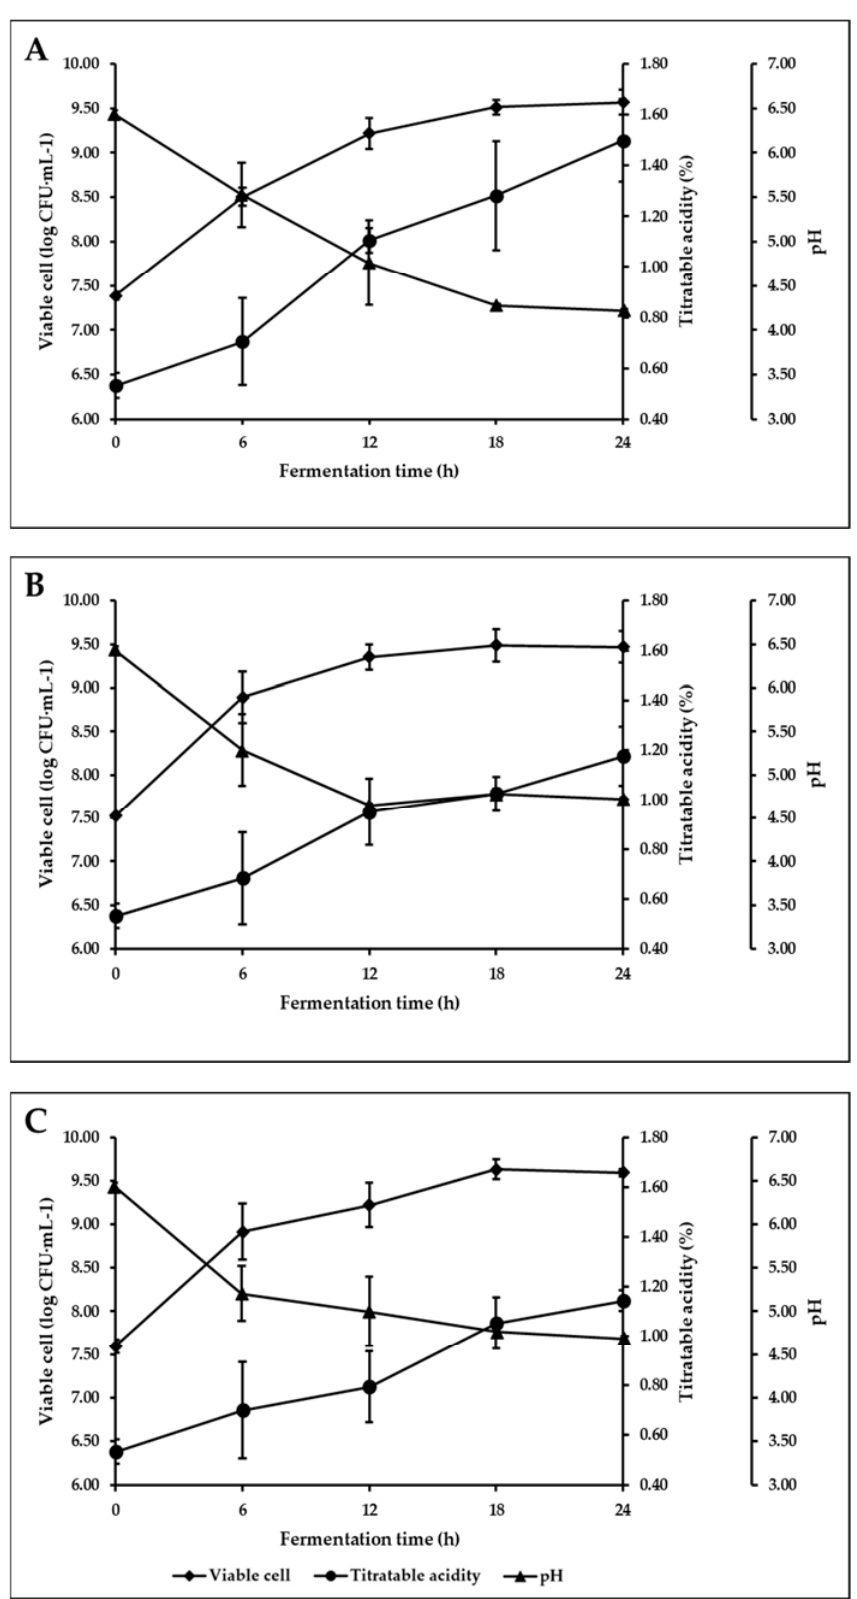
Figure 1. Growth and acid production ( n = 4) of: ( A ) L. plantarum WGK 4, ( B ) S. thermophilus Dad 11, and ( C ) L. plantarum Dad 13 during fermentation of black soy milk (24 h, 37 °C).